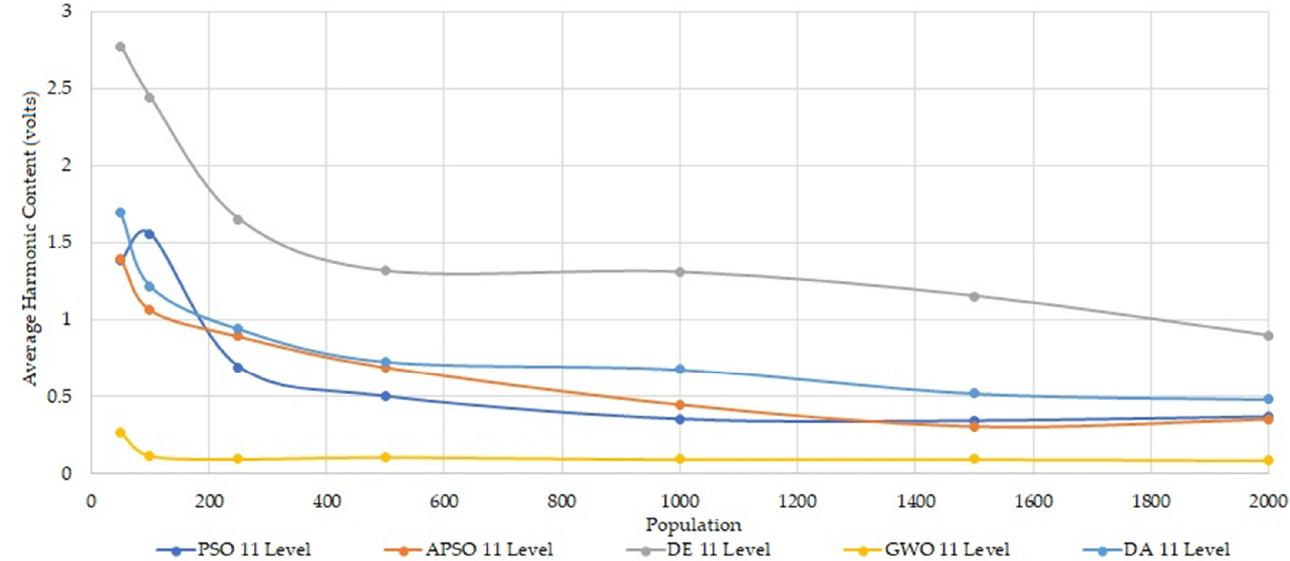
Figure 12. Algorithms’ average performance for an eleven-level inverter. Table 7. Statistical comparison for the average performance of algorithms.